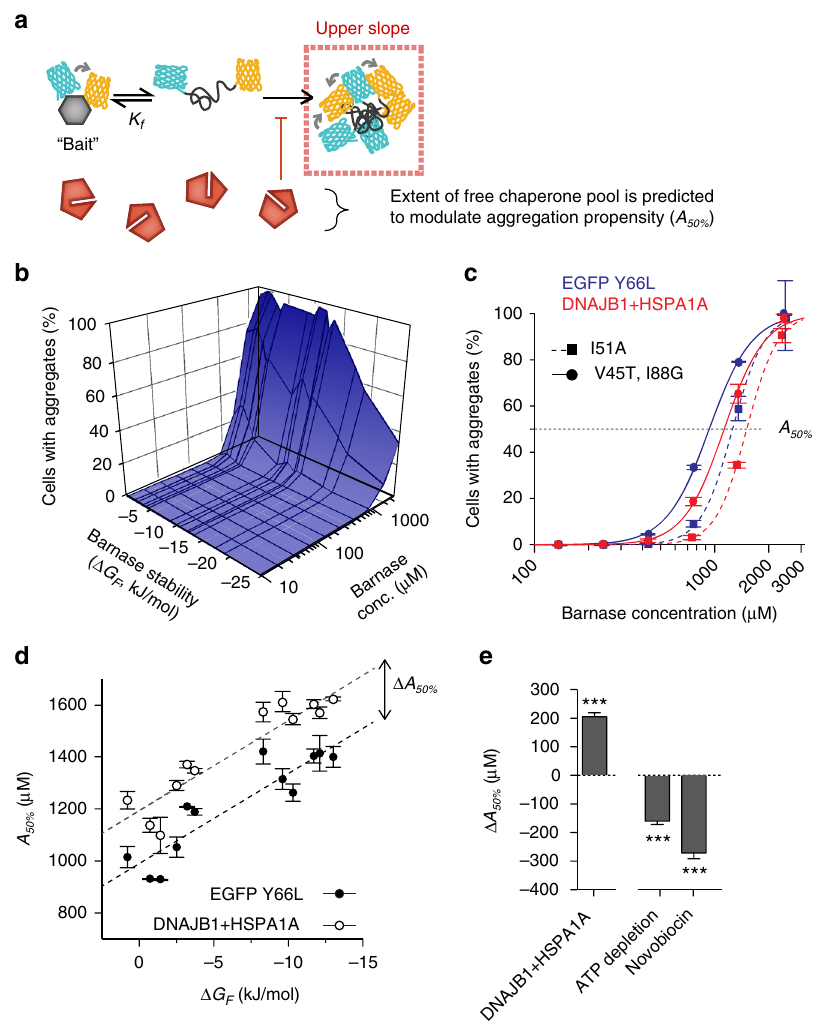
Fig. 5 Quantifying proteostasis by changes in biosensor aggregation propensity ( A 50% ). a Conceptual framework for how chaperone levels affect barnase- biosensor aggregation. b Baseline barnase aggregation “ landscape ” in cells as measured by the proportion of cells in the Upper-slope fl ow cytometry population. Data show mean of three replicates for each barnase mutant coexpressed with Y66L EGFP control. c Impact on chaperone overexpression on aggregation landscape. Data shows two of the barnase mutants and corresponding treatment regimes. Data points are means ± SD of three replicates. Chaperone treatment vs. control, p < 0.0001, extra sum-of-squares F test. d Impact of chaperone overexpression on A 50% values. Each data point re fl ects one mutant (means ± SEM of three replicates). Lines show linear regressions with same slope (preferred model by extra sum of squares F-test, p = 0.57). Δ A 50% is the translational offset, calculated for each mutant (example indicated by arrow). e Impact of proteostasis on changes in show chaperone co-expression (compared to Y66L EGFP negative control), treatment with proteostasis-modulating drugs (compared to untreated control). Data are means ± SEM of 12 mutants of barnase. Results of Wilcoxon signed rank test are shown: Results coded as *** p <